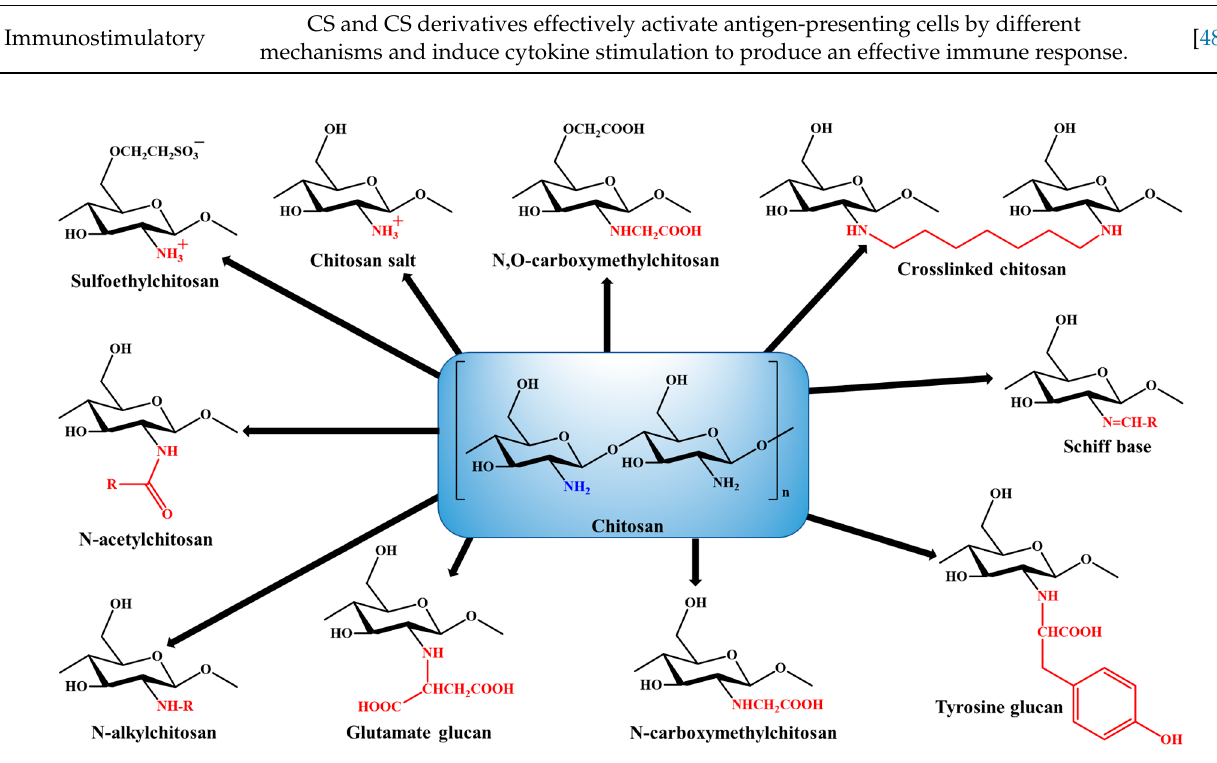
Figure 3. Chemical structures of different chitosan derivatives prepared by the functionalization of native chitosan.